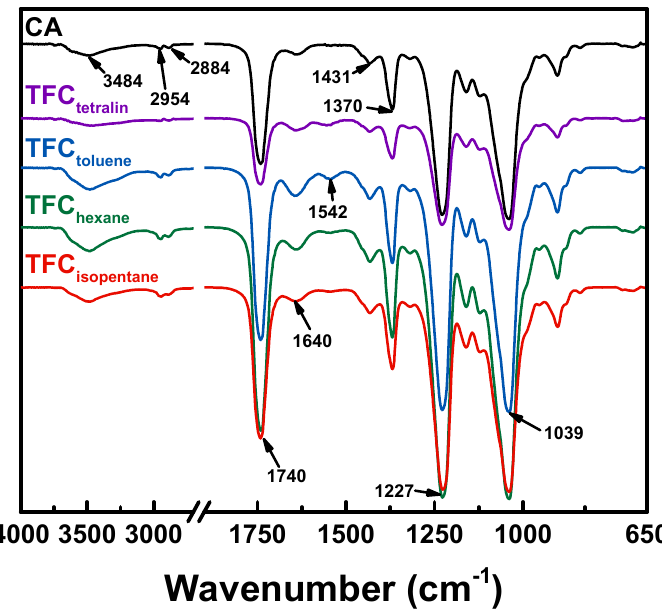
Figure 2. ATR-FTIR spectra of CA and TFC membranes.